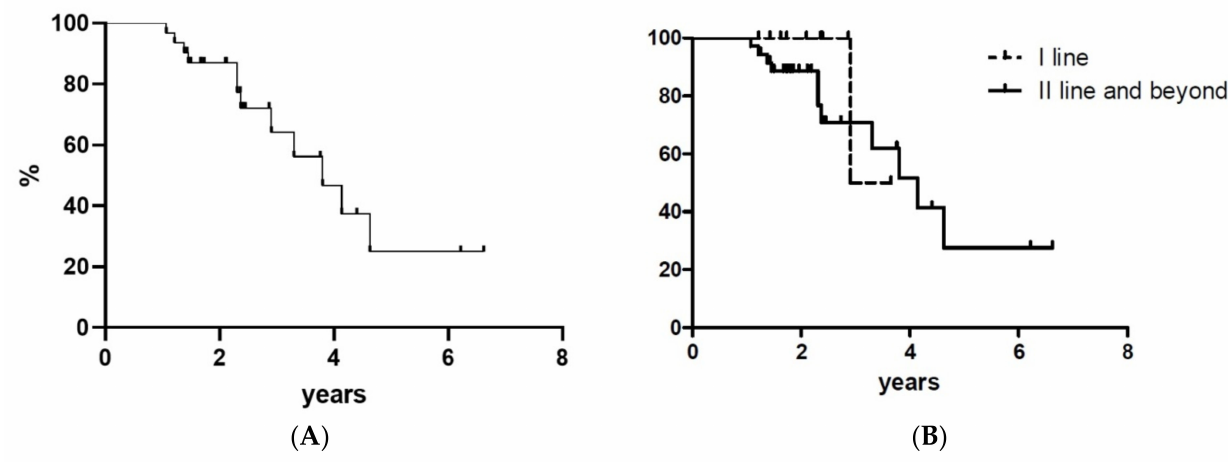
Figure 3. Time-to-next treatment for all treated patients (panel ( A )) and according to treatment line (panel ( B )). Y-axis represents patients